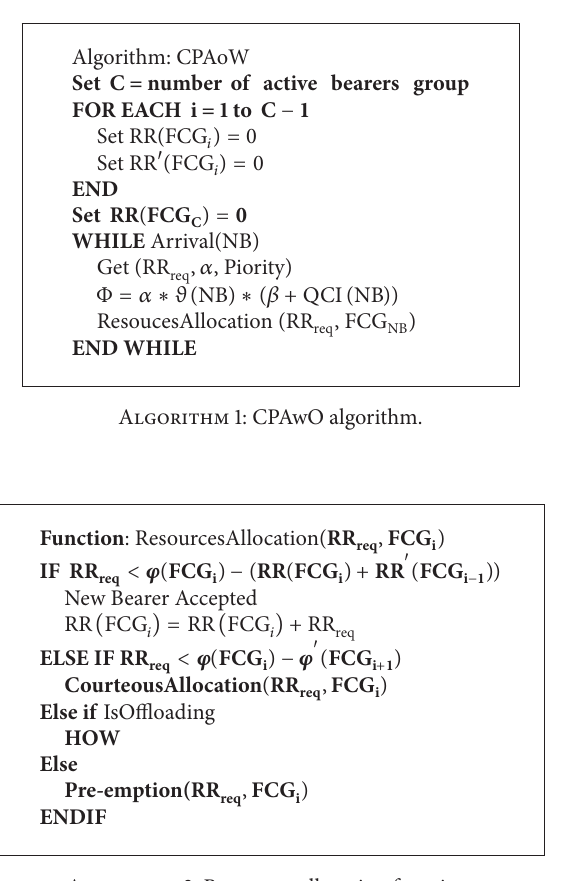
Algorithm 2: Resources allocation function.